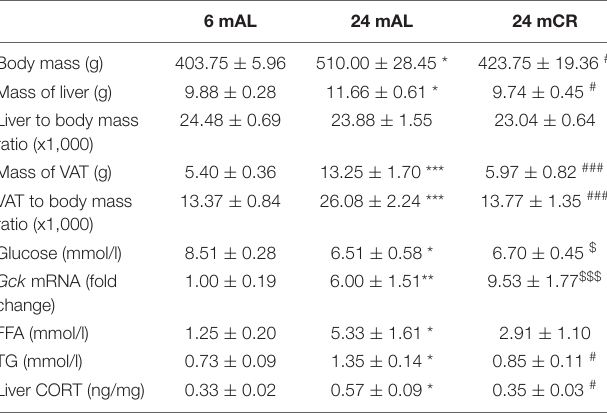
TABLE 1 | The effects of late-onset calorie restriction on morphological and biochemical